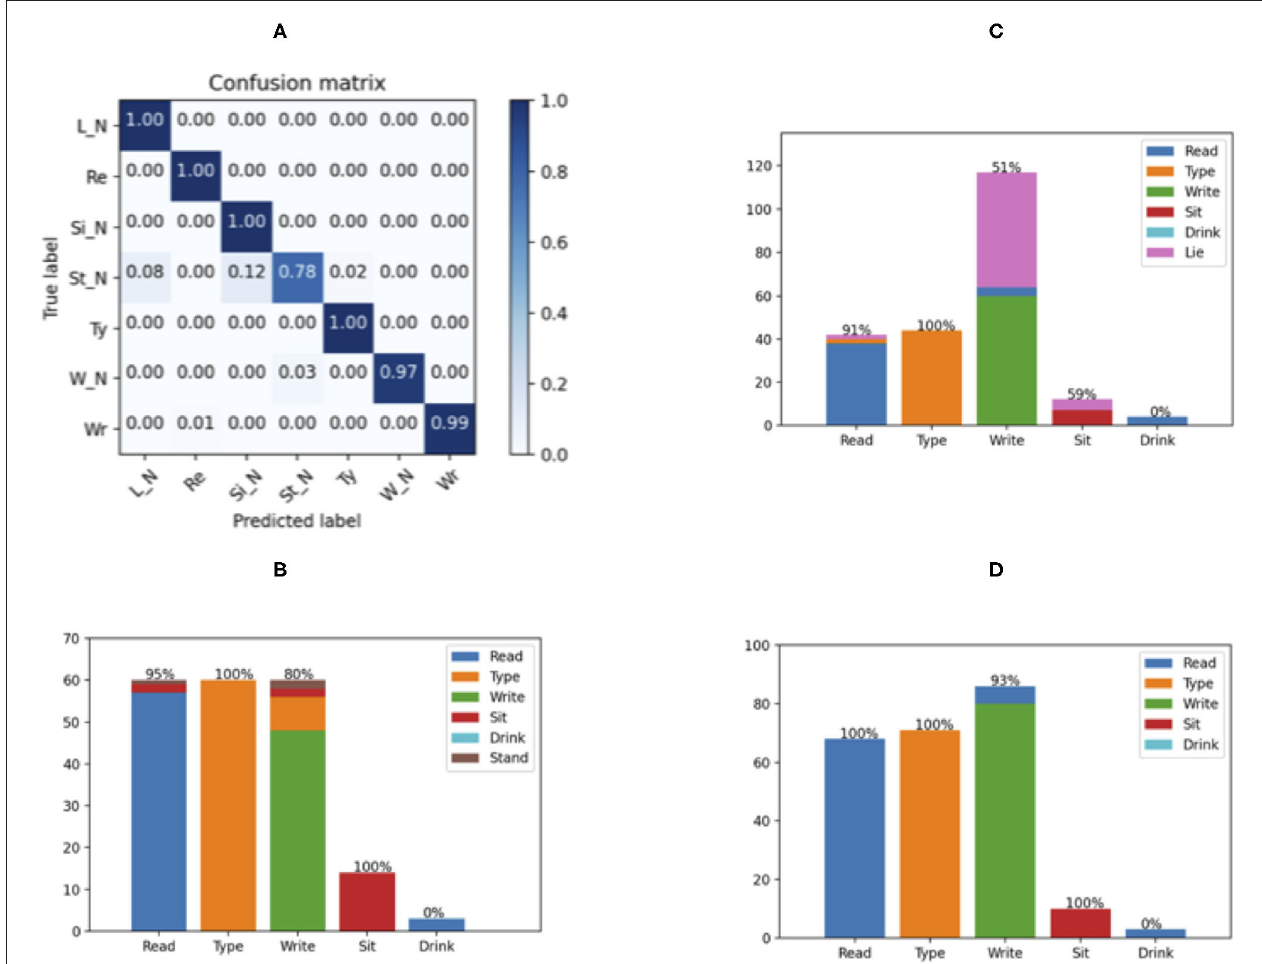
FIGURE 9 | Results of the real-time validation. The confusion matrix of the 2 subjects who have participated in the off-line experiment is shown in (A) ; whereas (B–D) show the compositional bar chart of each new subject. The values on top of each bar represent the ratio of correct recognition for each classes.